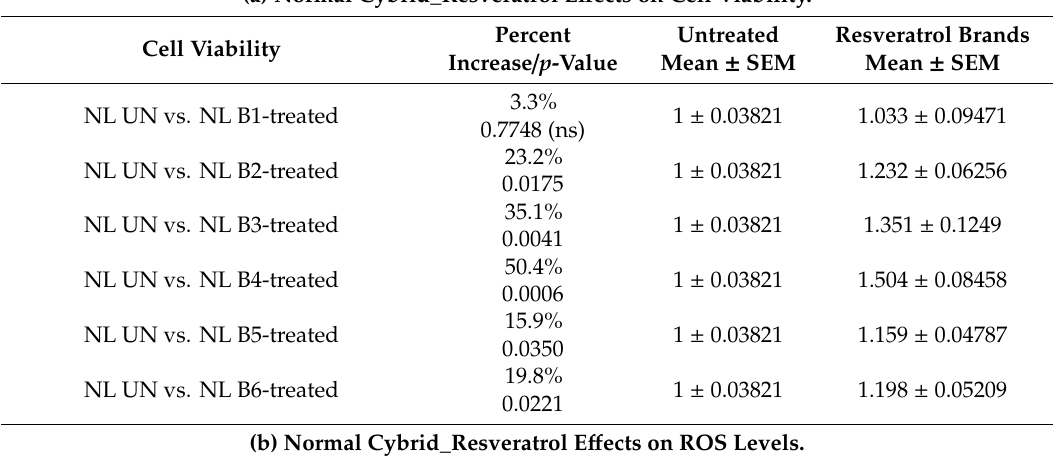
Table 2. E ff ects of resveratrol formulations on cell viability ( a , c ) and ROS levels ( b , d ) in normal cybrid cell lines ( a , b ) and ARPE-19 cell lines ( c , d